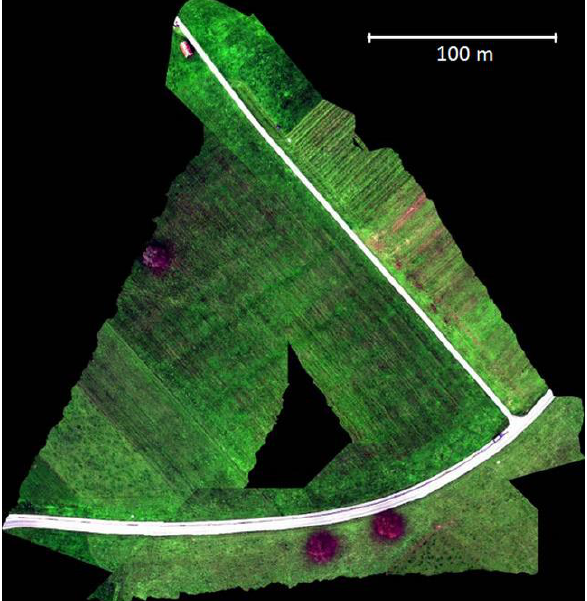
Figure 7: Overview of the hyperspectral calibration test flight, where three flight lines are used for the sensor calibration process.